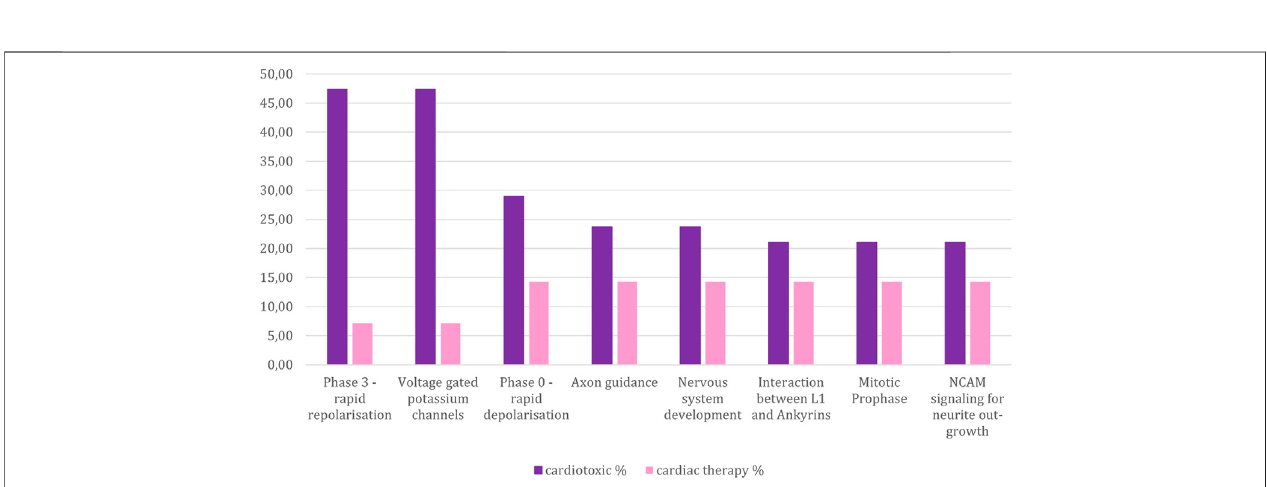
FIGURE 6 | Percentage of compounds from the toxic and non-toxic groups which are associated with those pathways that are connected to at least 20 % of the cardiotoxic compounds, yet less than 20% of the cardiac therapy compounds. Y-axes: compound-percentage, x-axes: pathways illustrated by Reactome terms.